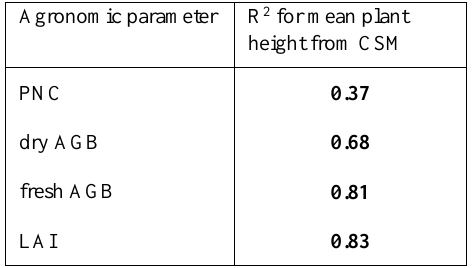
Table 2: Correlation (R 2 ) between CSM plant height and measured agronomic